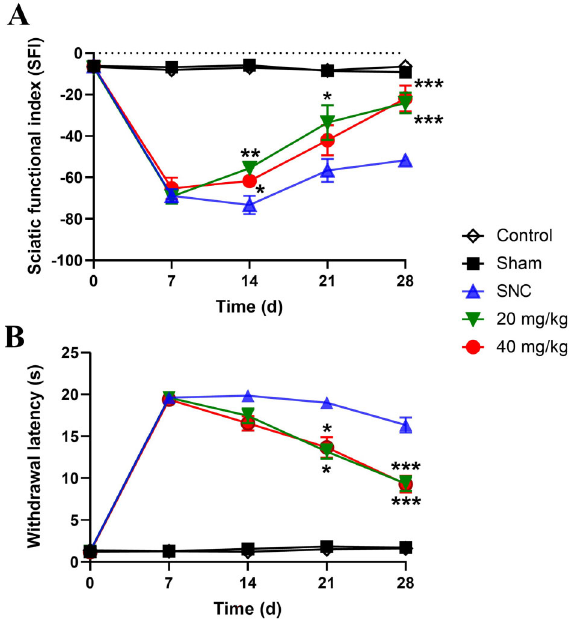
Figure 4. Effects of pinostrobin (PB) treatment (20 and 40 mg/kg) on motor ( A ) and sensory ( B ) functional recovery after sciatic nerve crush (SNC). Data are reported as means ± SE (n=6). *P o 0.05, **P o 0.01, and ***P o 0.001 vs SNC group